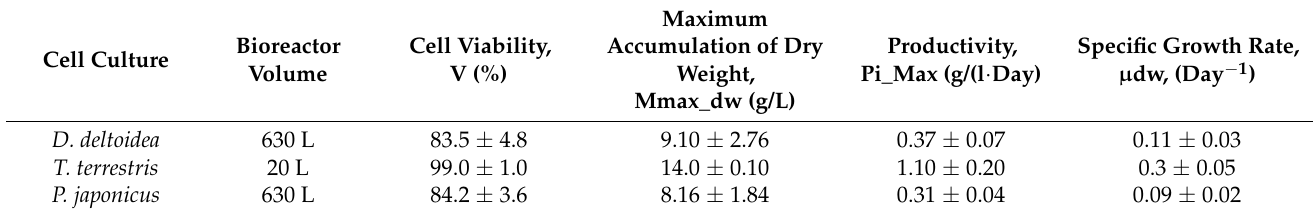
Table 2. Growth and viability characteristics of the suspension cell cultures of D. deltoidea , T. terrestris and P. japonicus grown in bioreactors. All parameters were calculated based on dry